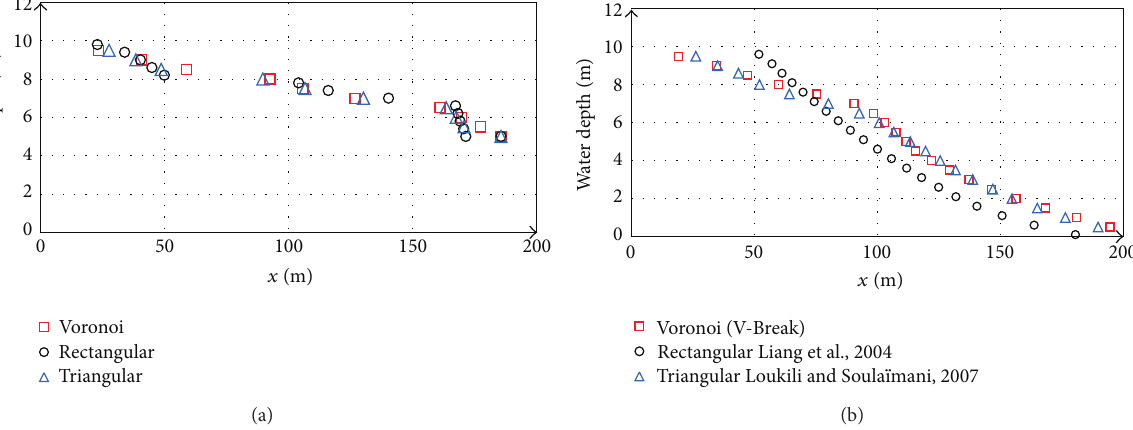
Figure 9: The comparison among Voronoi, rectangular [11], and triangular [14] mesh grids. (a) Wet bed and (b) dry